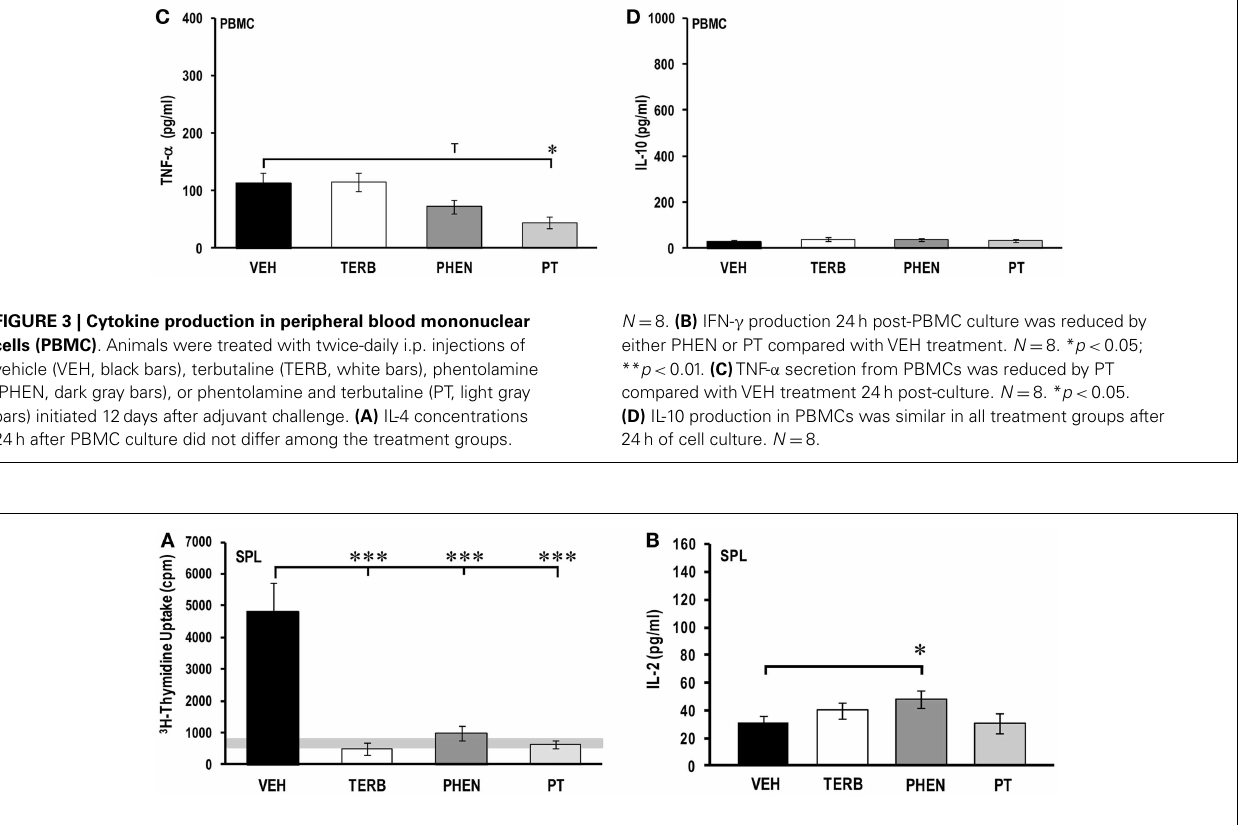
FIGURE 4 | Ex vivo proliferation and IL-2 production by spleen (SPL) cells 72 and 24h post-culture, respectively . Animals were treated with twice-daily i.p. injections of vehicle (VEH, black bars), terbutaline (TERB, white bars), phentolamine (PHEN, dark gray bars), or phentolamine and terbutaline (PT, light gray bars) initiated 12days after adjuvant challenge. (A) 3 H-Thymidine incorporation into spleen cells was significantly lower in